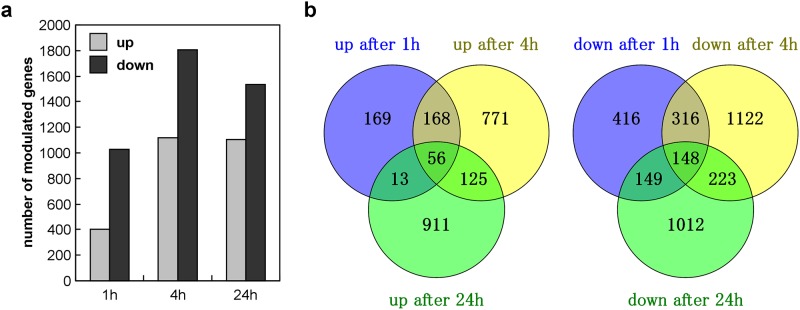
High HP modulates hundreds of genes.(a) number of genes up- and down-regulated at least 2-fold after 1, 4 and 24 h of pressurization. (b) Venn diagrams showing the overlap between genes up-regulated (left) and down-regulated (right) at different time points.